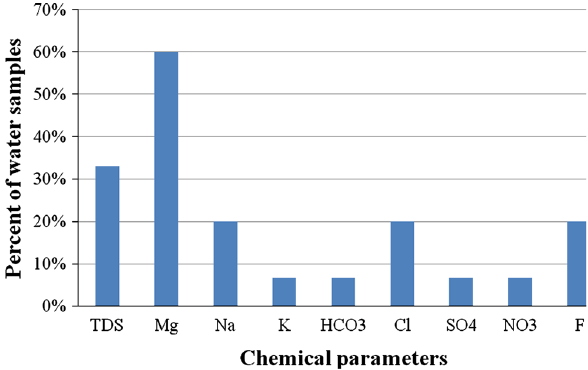
Fig. 3 Percent of groundwater samples exceeding the safe drinking water quality standard